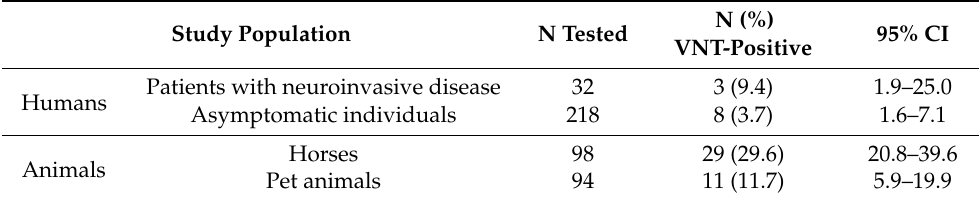
Table 1. Tahyna virus seroprevalence in Zagreb and the surrounding area.